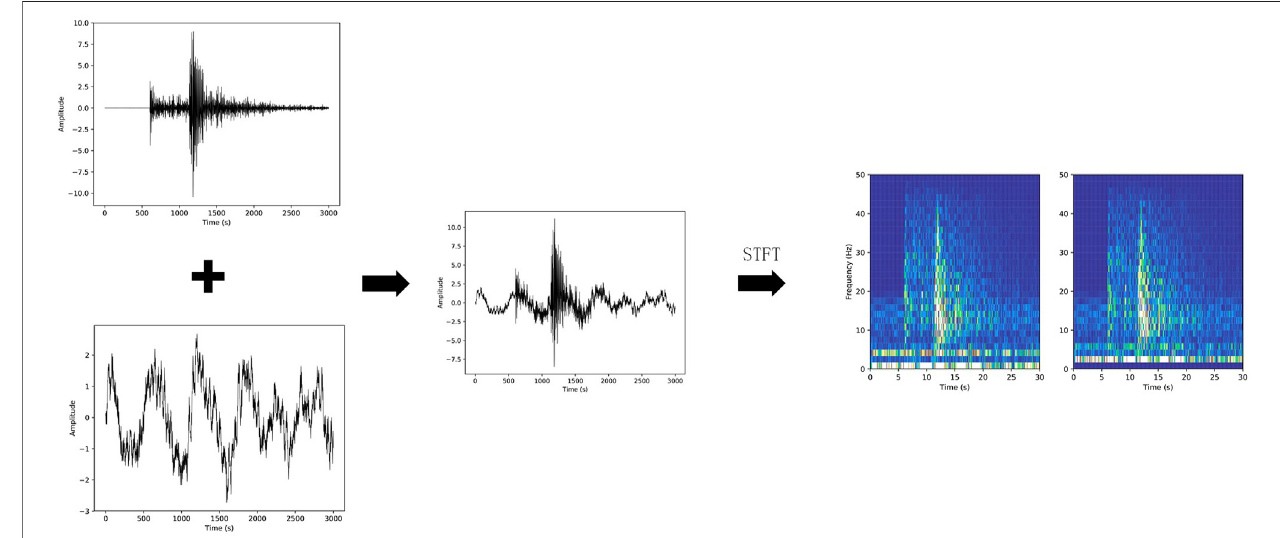
FIGURE 3 | The pipeline from raw data to the input of the network.